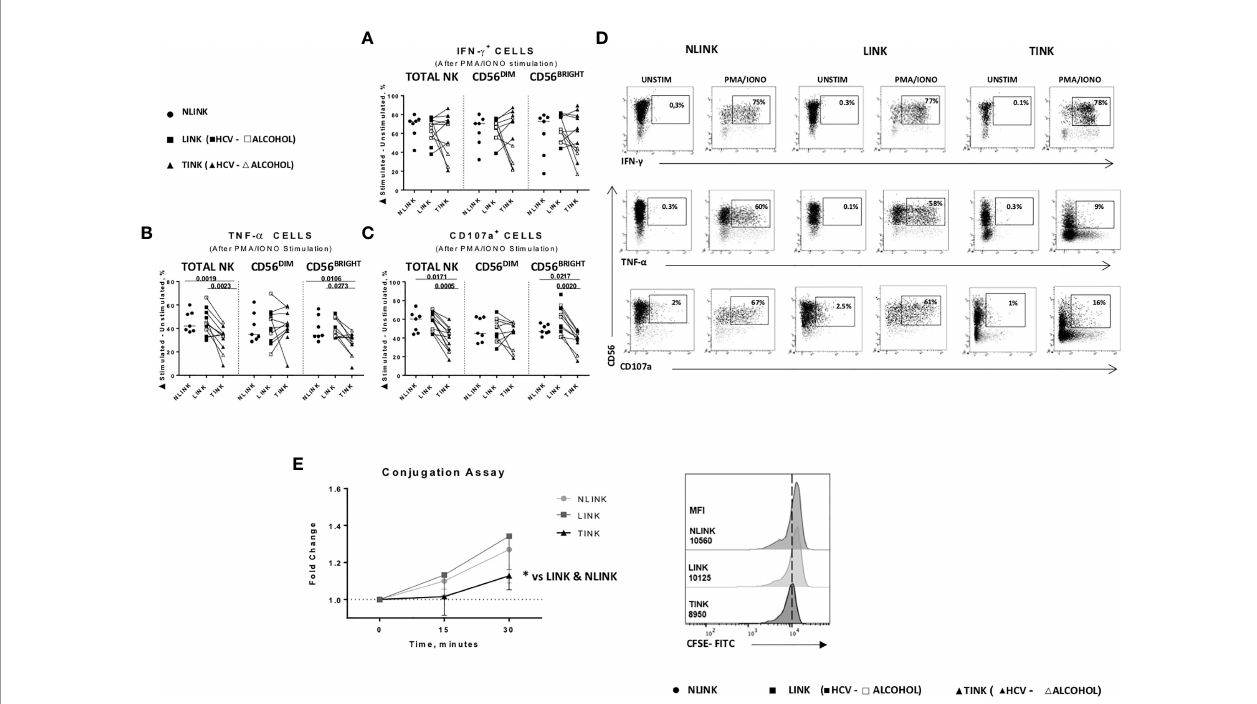
FIGURE 5 | Functional analysis of NLINK, LINK, and TINK. (A, B) IFN- g and TNF- a production in in fi ltrating NK cells was evaluated with or without phorbol 12- myristate 13-acetate and ionomycin incubation for 4(h) (C) The cytotoxic potential of NK cells was measured by CD107a degranulation assay. (D) Representative dot plots showing IFN- g , TNF- a , and CD107a expression in tumor- and liver-in fi ltrating NK cells from NLINK, LINK, and TINK upon PMA/ionomycin stimulation. (A – C) Data are presented as the delta between the frequency of cytokine + or CD107a + NK cells in unstimulated and stimulated samples. Horizontal lines indicate median values. (E) NK cell adhesion to target cells (K562) was evaluated by staining NK cells and K562 with two distinct fl uorescent dyes (anti-CD3 and anti-CD56 and 0.5 m M CFSE, respectively). The effector-to-target ratio was 5:1. Cells were incubated at 37°C for 0, 15, and 30 min, followed by fi xation. Median fl uorescence intensity (MFI) ratio was measured at different time points (left panel). Cell conjugation is presented as MFI values of CD56 + cells in CFSE-FITC target cells. Comparison of TINK, NLINK, and LINK at 30 min (right panel). (A – E) NLINK ( n = 7), LINK ( n = 12), and TINK ( n = 12) *p <